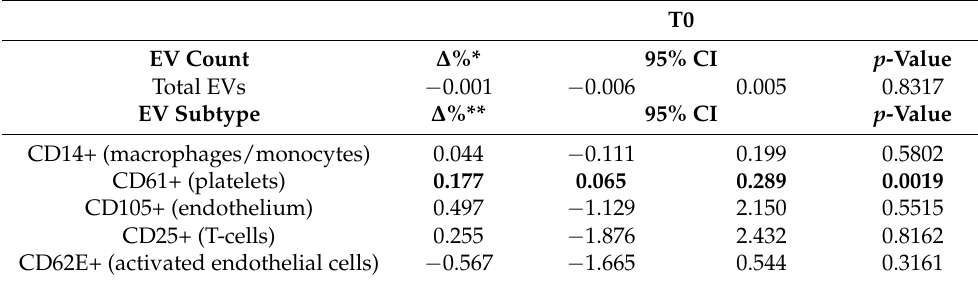
Table 2. Relationships between National Institute of Health Stroke Scale (NIHSS) at the onset of the acute event and count of EV and EV subtype at T0.